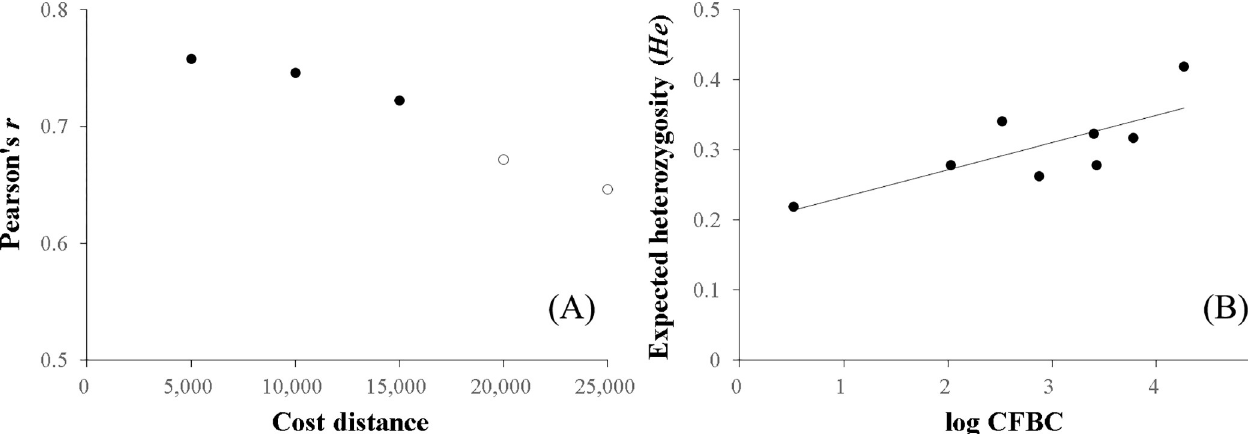
Fig 10. Relationship between the genetic diversity of nutria populations and their habitat connectivity. (A) Pearson’s r coefficients between the expected heterozygosity ( He ) of eight nutria populations and their habitat current flow betweenness centrality (CFBC) measured at each cost distance threshold of 5,000 to 25,000 with intervals of 5,000 in the Nakdong River Basin. Closed circles indicate significant correlations ( p < 0.05). The strongest correlation was observed at a cost distance of 5,000. (B) Scatter plot and fit line between He and CFBC measured at the cost distance threshold of 5,000.